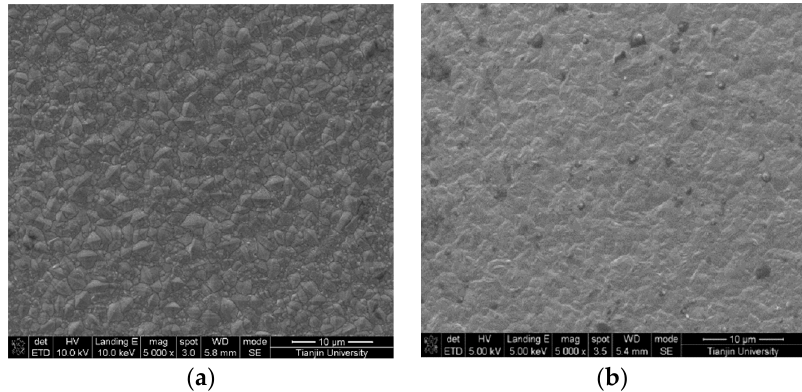
Figure 15. SEM images of the Ni coating and Ni/nanodiamond composite coating.